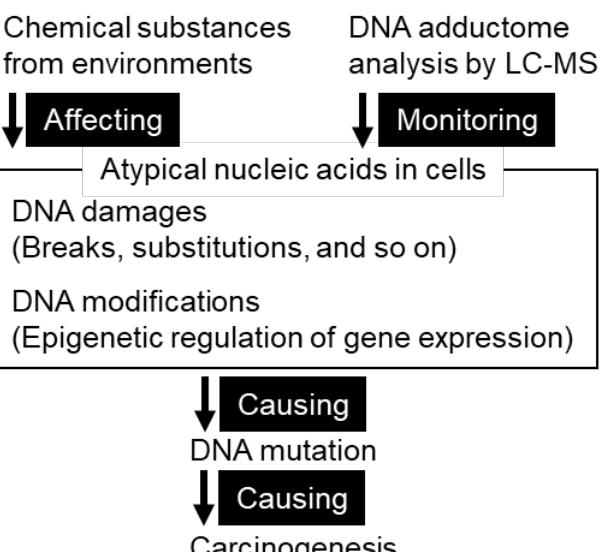
Figure 1. A schematic illustration of DNA adductome analysis to monitor DNA damages in chemi- cal carcinogenesis. Many chemical substances affect DNA damages and DNA modifications. These atypical nucleic acids potentially cause DNA mutation and carcinogenesis. Using liquid chromatog- raphy coupled with mass spectrometry, the accumulation of DNA damages can be monitored by DNA adductome